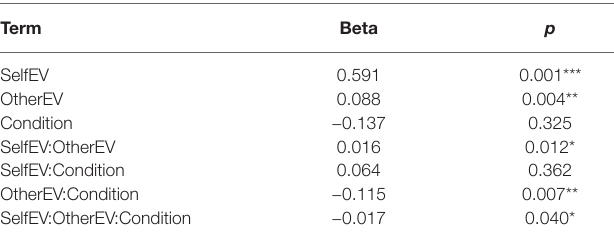
TABLE 1 | Estimates and p ’s, Study